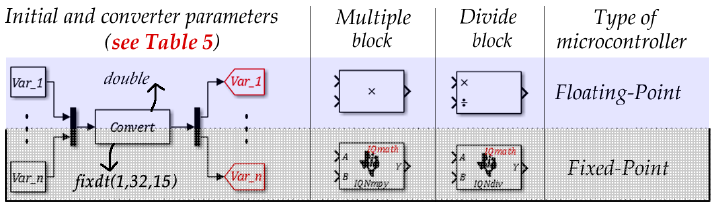
Figure 10. Fixed-point and Floating-point different